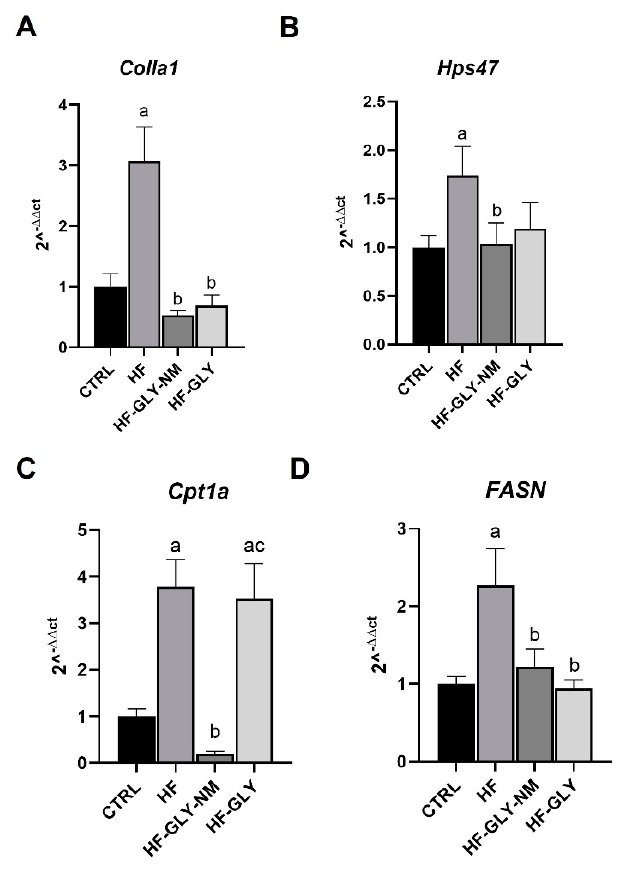
Figure 4. Gene expression of collagen type I, α 1 ( ColIa1 ), heat shock protein 47 ( Hsp47 ), fatty acid synthase ( FASN ) and carnitine palmitoyltransferase 1a ( Cpt1a ). Relative mRNA level of ( A ) ColIa1 , ( B ) Hsp47 , ( C ) FASN and ( D ) Cpt1a in liver from CTRL (Group I), HF (Hepatic fibrosis; Group VII), HF-GLY-NM (Group IX) and HF-GLY (Group X). Values are expressed as fold change with respect to CTRL ± SD (n = 3). GADPH expression levels were used as the housekeeping gene. (Group I): Control untreated rats allowed free access to food and water; HF (Group VII): rats intraperitoneal injected with CCl 4 three times a week for two weeks; HF-GLY-NM (Group IX): HF rats treated with encapsulated Galunisertib-LY2157299 three times a week for two weeks following CCl 4 injections; HF-GLY (Group X): HF rats treated with free Galunisertib-LY2157299 three times a week for two weeks following CCl 4 injections. Significative values were reported with respect to Group I CTRL, a = p < 0.05; to Group VII HF, b = p < 0.05; to Group IX Hf-GLY-NM, c = p < 0.05;. The expression levels of two genes involved in fatty acid metabolism, i.e., FASN which participates in the synthesis of fatty acid and Cpt1a which participates in fatty acid oxidation were assayed (Figure 4C,D). The mRNA level of both Cpt1a and FASN were up- regulated in CCl 4 -induced HF indicating an imbalance in lipid homeostasis (Figure 4C,D). FASN mRNA of CCl 4 -induced HF rats was downregulated to levels comparable to control untreated animals by both GLY and GLY-MN treatment. Surprisingly, the mRNA level of Cpt1a was strongly reduced only after GLY-MN but not after GLY treatment. 4. Discussion In the present study, the antifibrotic properties of the TGF- β 1 inhibitor LY2157299 (GLY), encapsulated in polymeric nanomicelles, were investigated in a rat model of CCl 4 -